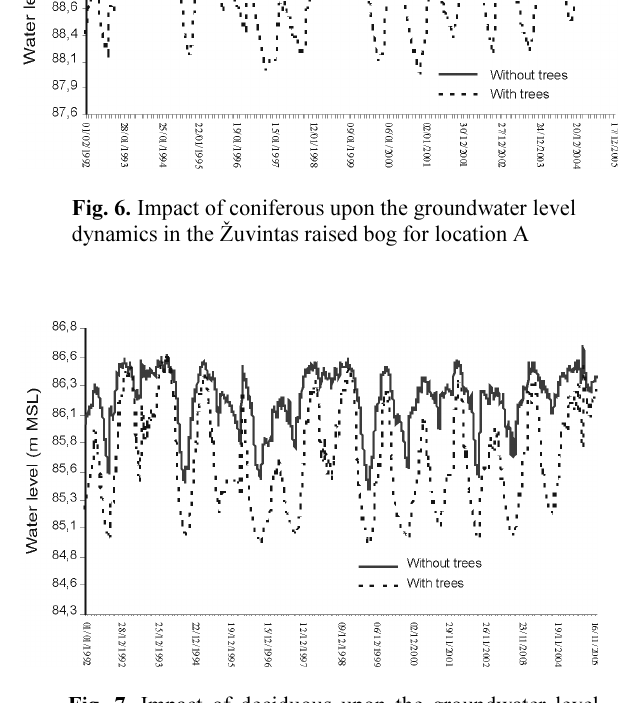
Fig. 7. Impact of deciduous upon the groundwater level dynamics in the Amalvas wetland for location